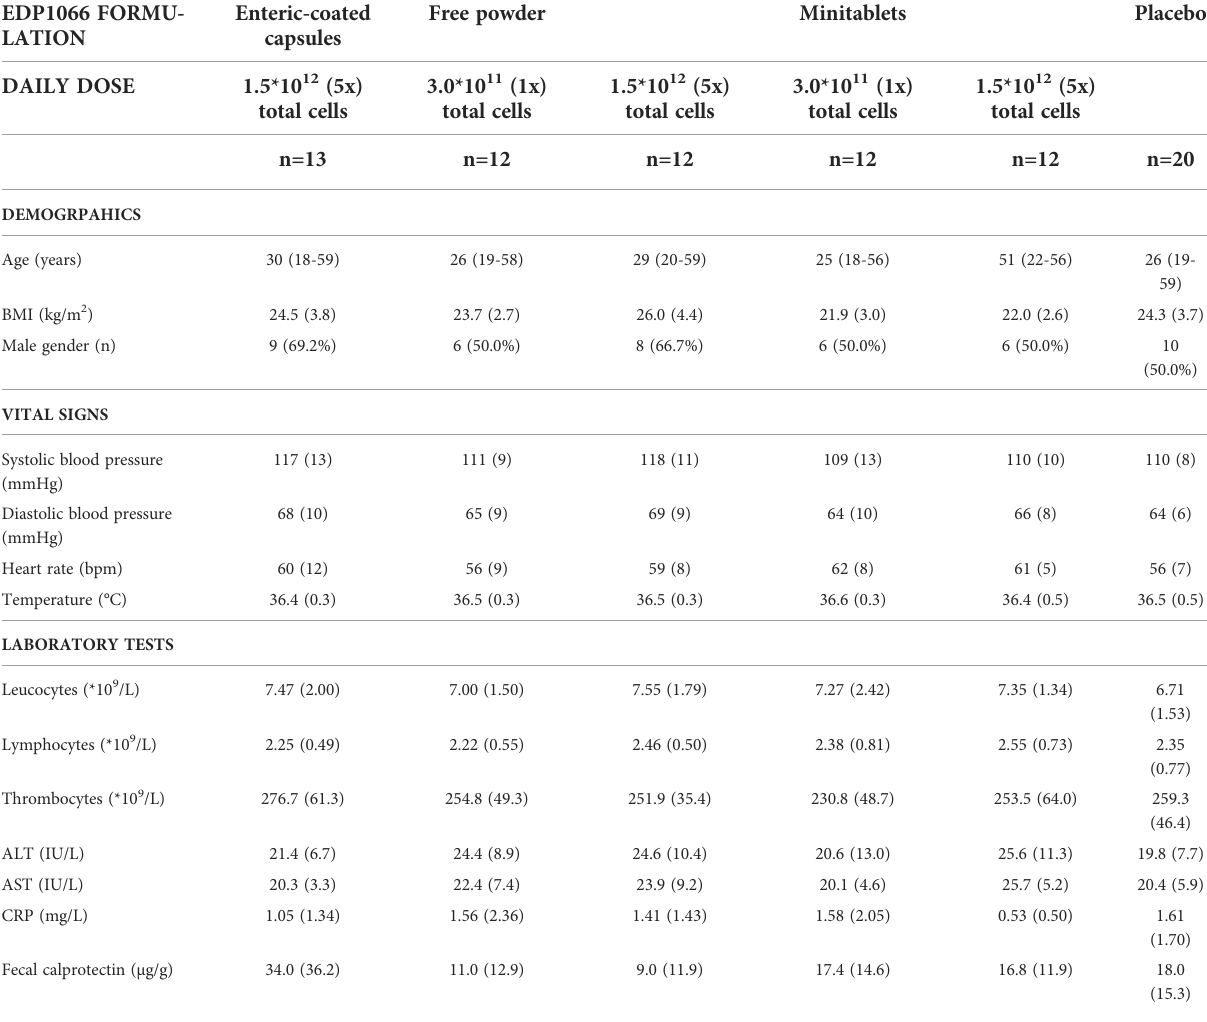
TABLE 2 Baseline